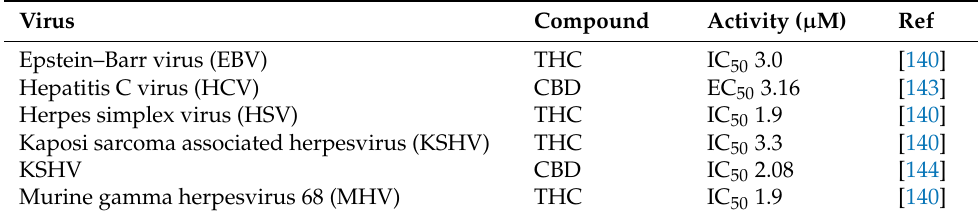
Table 4. Efficacy of cannabinoids against virus